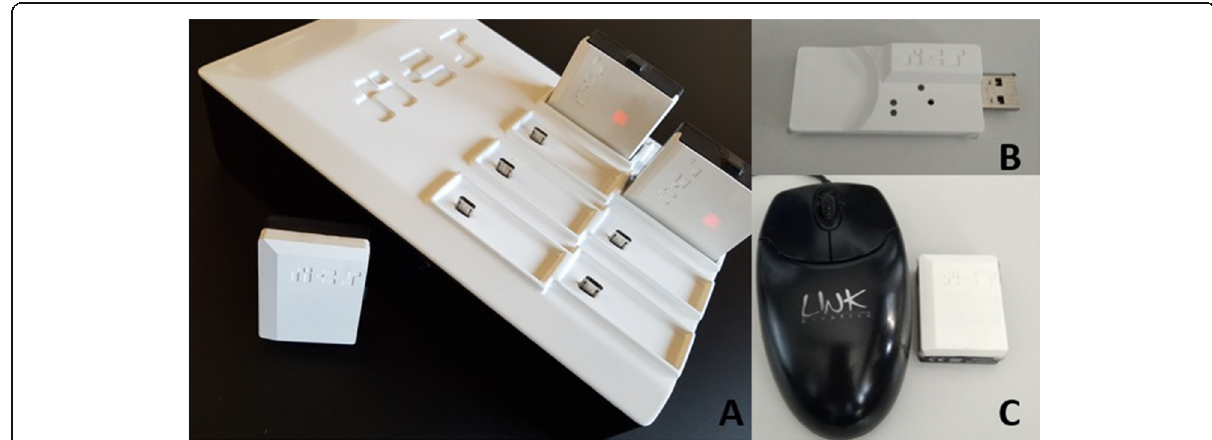
Fig. 1 The SHoW Motion 3D kinematic tracking system is composed of a set of five sensors (here shown over a charger, a ), a USB receiver ( b ) that plugs to any laptop and a specific software that must be installed in the laptop. The sensors have approximately the size of a matchbox ( c ). The sensors, charger straps and receiver weight less than a kilogram and fit easily in any small suitcase